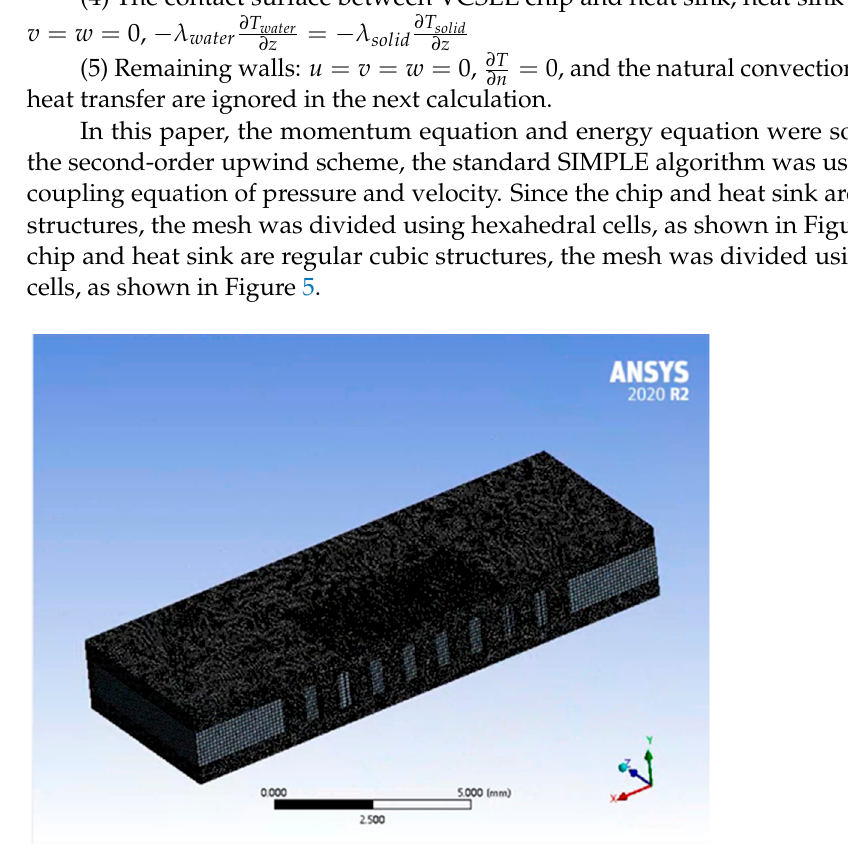
Figure 5. Schematic diagram of dividing the grid.